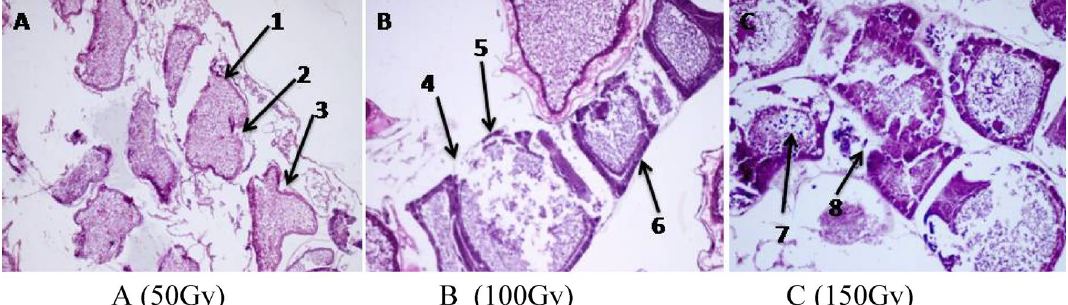
Figure 2. (A–C) Longitudinal sections in ovarioles of female emerging from pupae irradiated with gamma rays. 1, Rectangular oocyte; 2, absence of nurse cells; 3, irregular oocyte; 4, rupture of the epithelial cells; 5, absence of the epithelial cells; 6, shrinking oocyte; 7, deterioration; 8, separation.